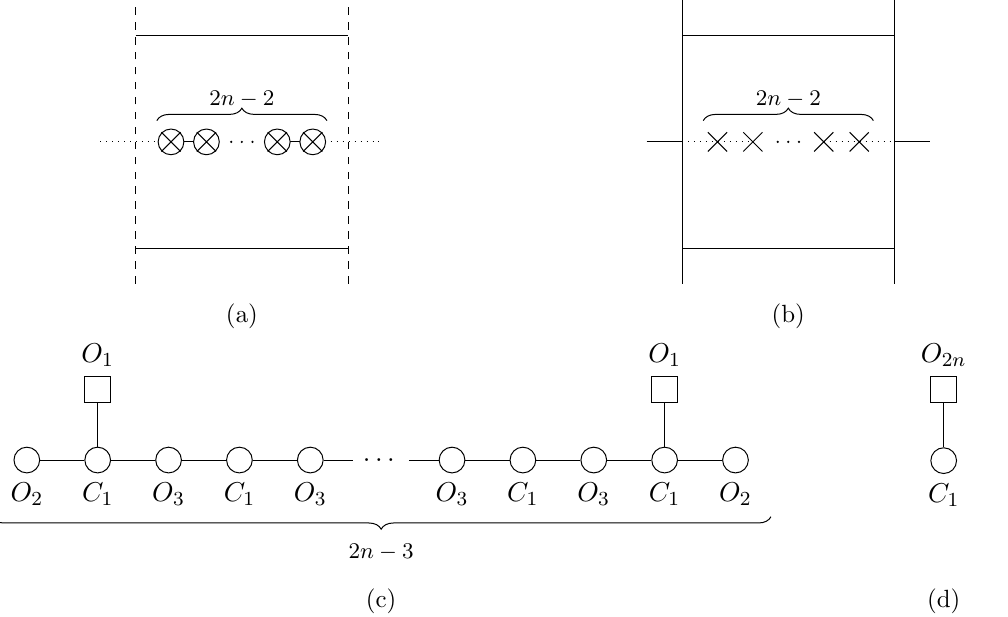
Figure 51. D n subregular singularity. (a) Brane subsystem that represents the moduli space generated by a single D3-brane in the leftmost interval of (cid:12)gure 50. (b) After performing S-duality on (a) the moduli space generated by this single D3-brane can be understood as a Coulomb branch. (c) Quiver for brane system (a), its Higgs branch is the Kleinian singularity M H = D n . (d) Quiver corresponding to brane system (b), its Coulomb branch is M C = D n . The g O 3 (cid:0) planes contribute to the quiver as half (cid:13)avors. Note that [6] already discusses quivers (c) and (d) and their